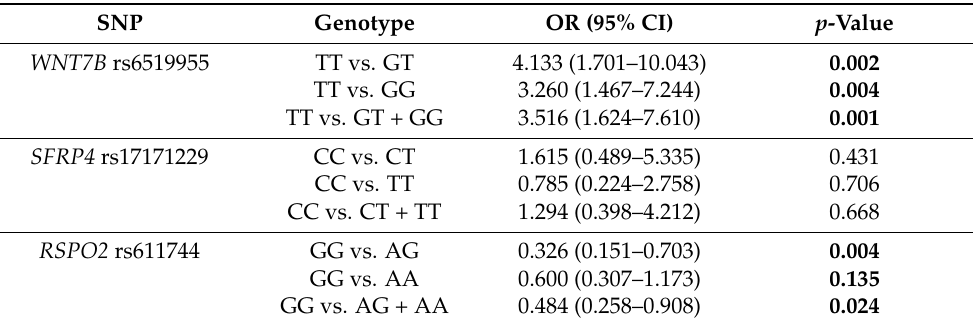
Table 3. The impact of WNT7B rs6519955, SFRP4 rs17171229 and RSPO2 rs611744 on the development of DC.